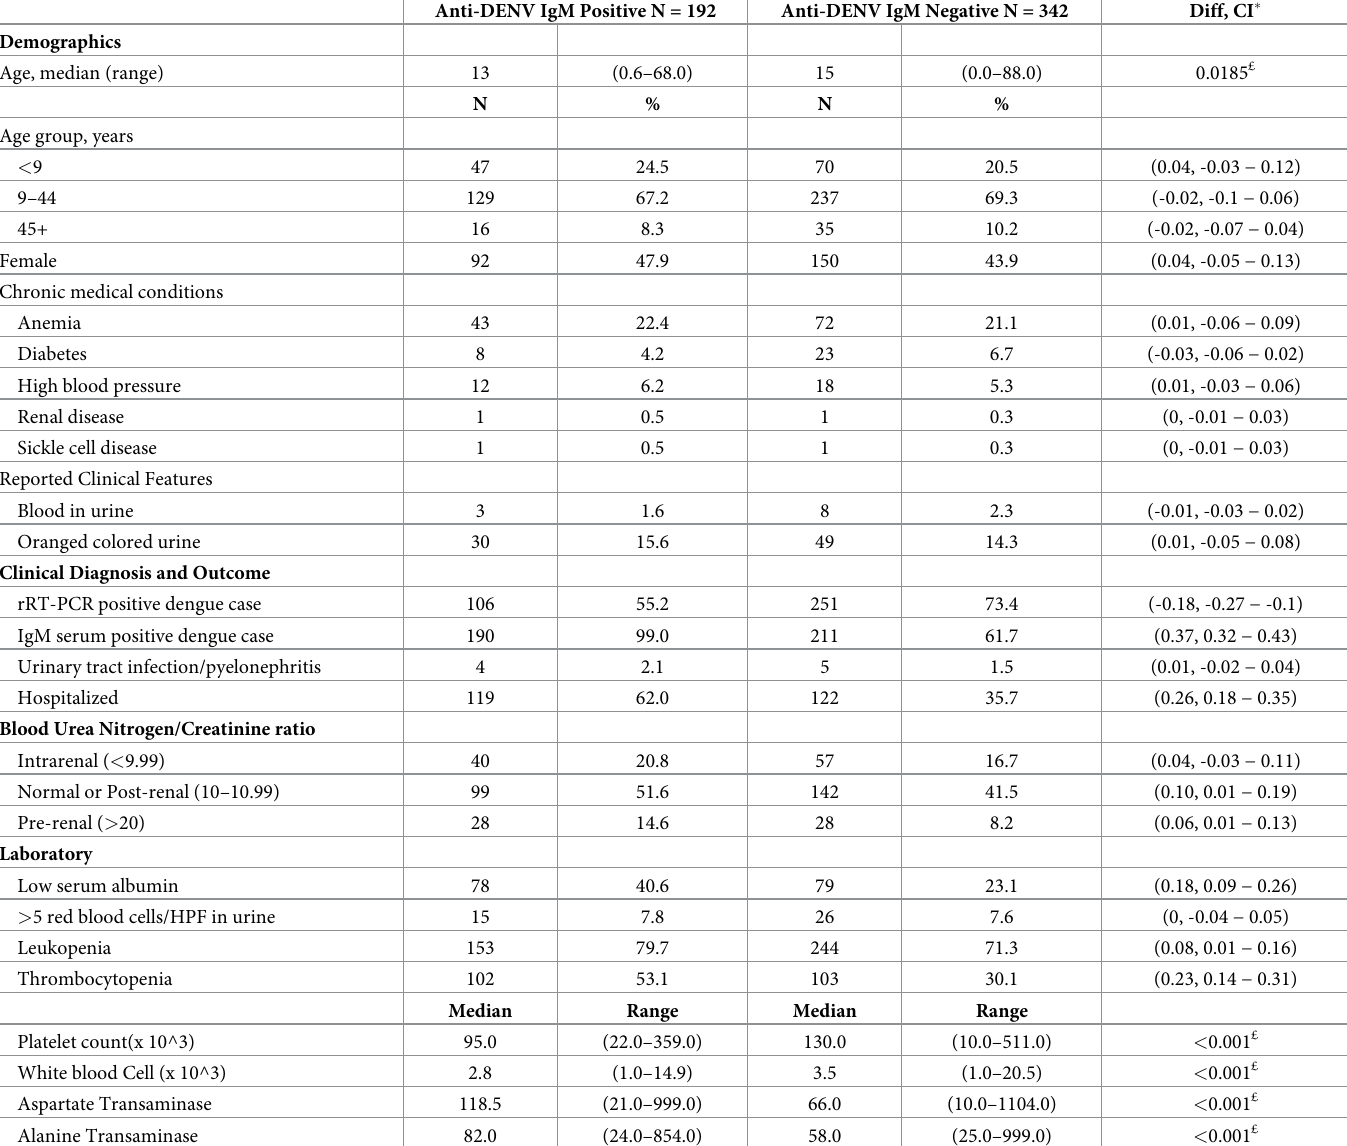
Table 1. Participants’ demographics and clinical features. Comparison of demographic and clinical features by urine anti-DENV IgM status among laboratory-positive dengue cases. Anti-DENV IgM Positive N =